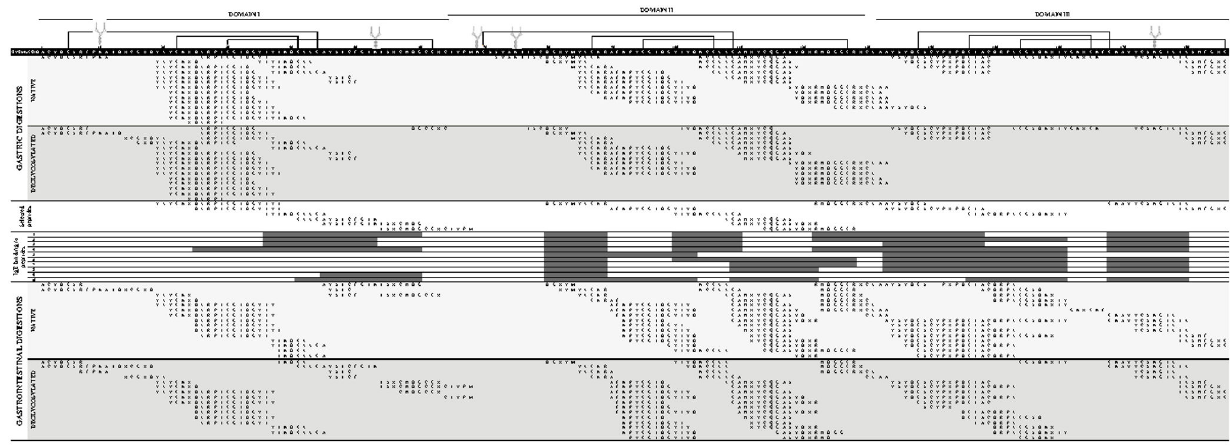
Figure 5. Peptide identification and IgE binding properties. Peptide sequences, identified by RP-HPLC-MS/MS, in the gastric (60 min) and subsequent duodenal digests of OM and dOM (60 min of gastric followed by 30 min of duodenal digestion), and IgE binding, estimated by immunodot with 10 sera of egg-allergic patients (patients 1-10, Table 1), of 17 synthetic peptides selected within the peptides identified in the simulated digestions. doi: